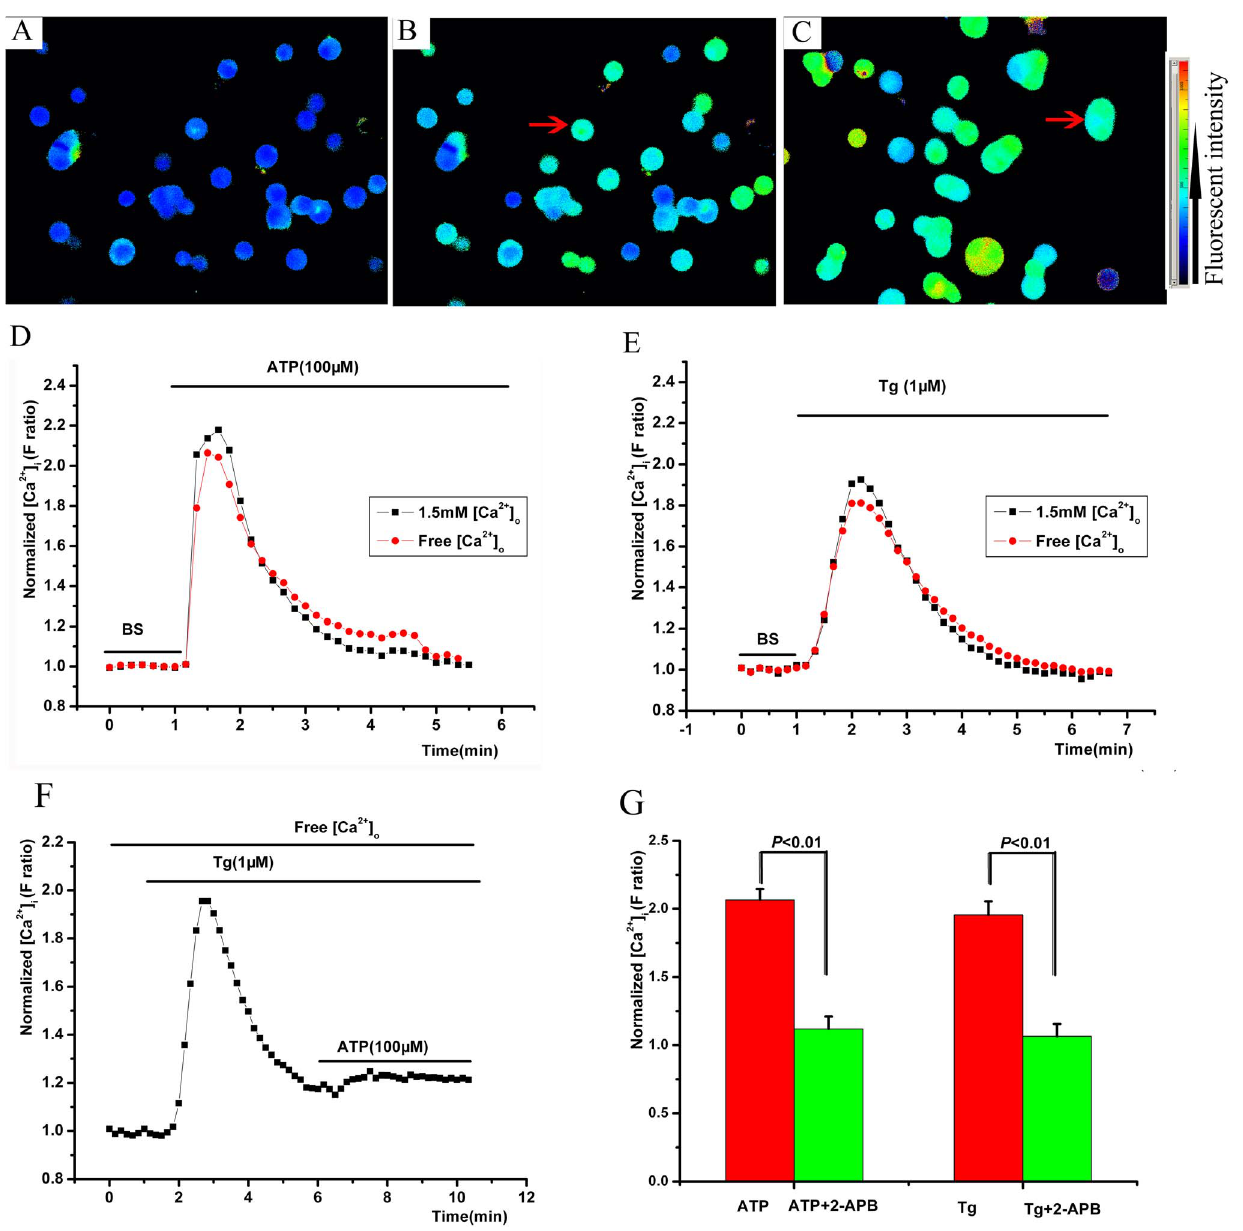
Figure 2. Extracellular ATP induced a [Ca 2 + ] i transient elevation in macrophages. A, representative calcium imaging in control solution. B, calcium imaging with ATP (100 m M), the red arrow showed the peak [Ca 2 + ] i . C, calcium imaging with thapsigargin (Tg, 1 m M), the red arrow showed the peak [Ca 2 + ] i . D, time series of the ratio of fluorescence intensity at excitation wavelengths of 340 and 380 nm (F ratio) during the application of ATP. E, time series of the mean F ratio during the application of Tg. F, time series of the mean F ratio during the sequential application of Tg and ATP. G, 2-aminoethoxydiphenyl borate (2-APB, 100 m M) inhibited the [Ca 2 + ] i transient elevation induced by both ATP and Tg. BS, bath solution.